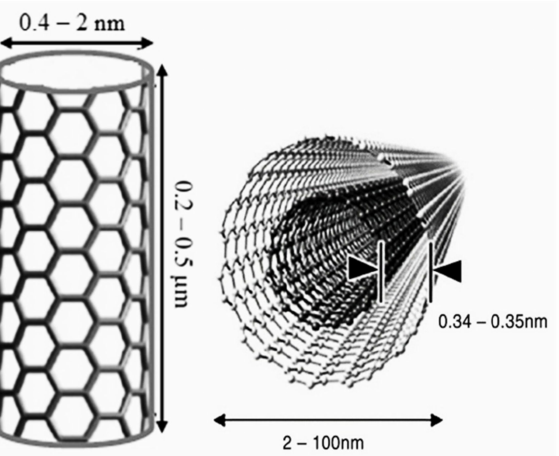
Figure 1. Types of typical dimensions of CNTs, SWCNTs ( left ) and MWCNTs ( right ). Reprinted with permission from